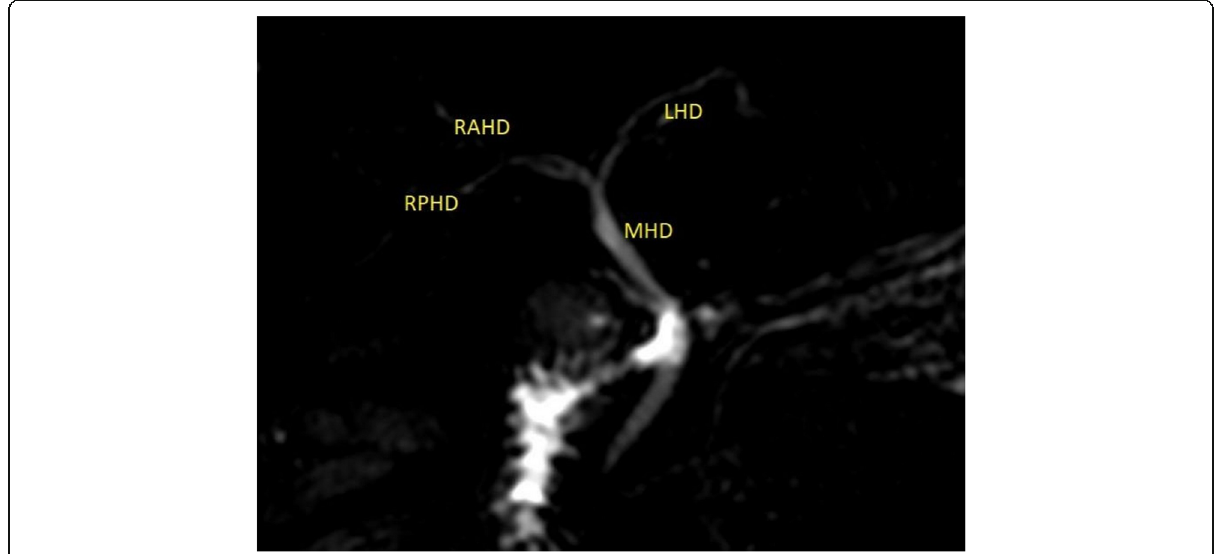
Fig. 3 MRC (RARE) Huang type A1: RPHD drain into the RAHD (RPHD, right posterior hepatic duct; RAHD, right anterior hepatic duct; LHD, left hepatic duct; and MHD, main hepatic